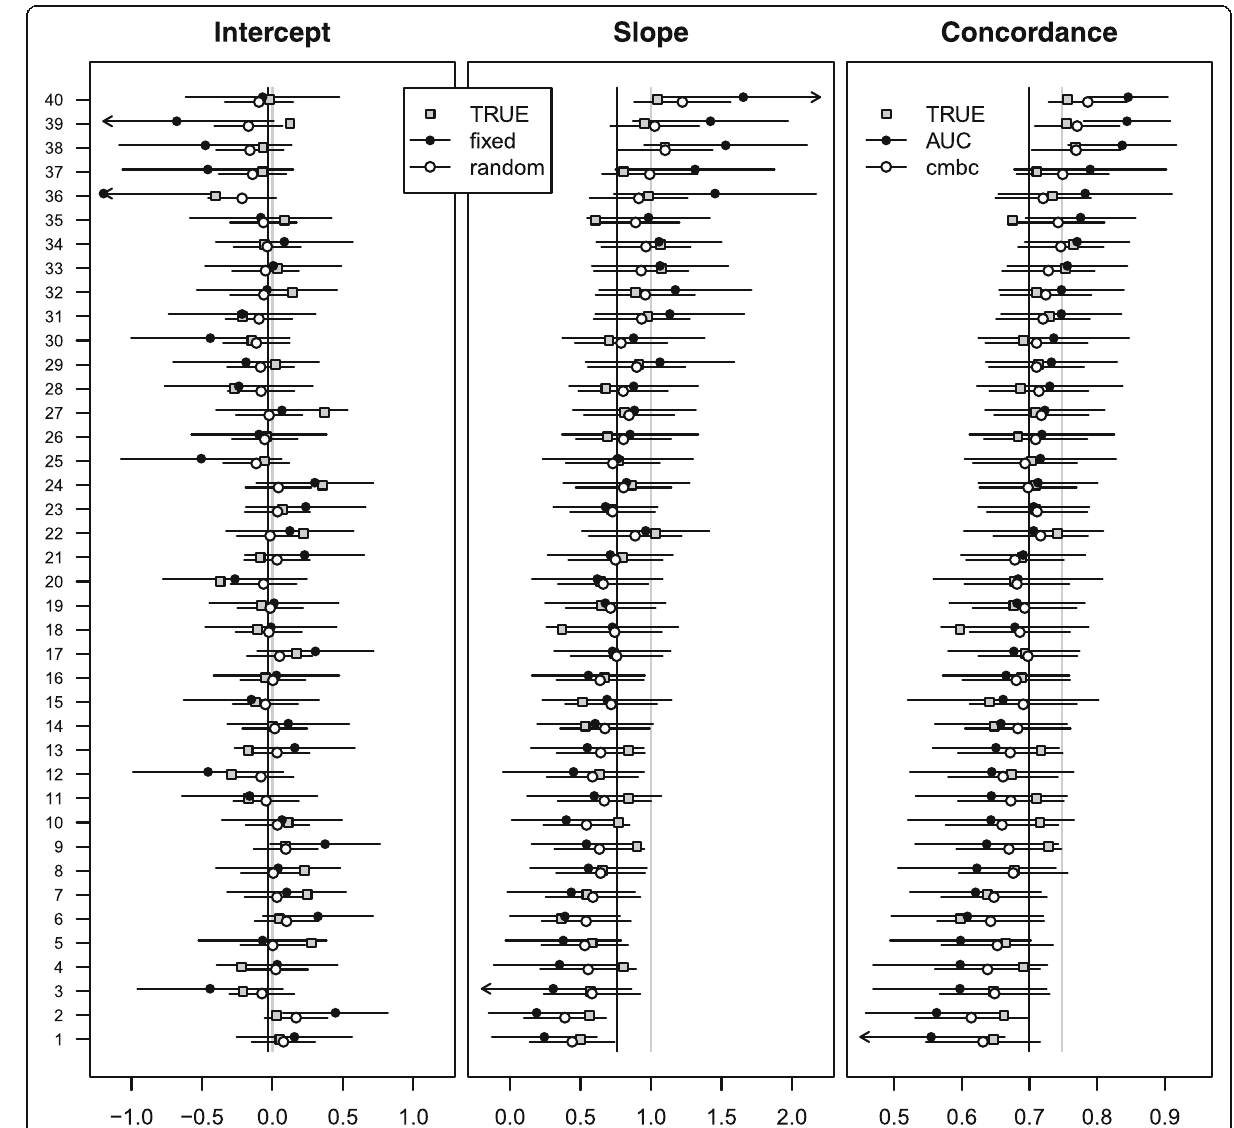
Fig. 6 Performance measures across 40 centers of 200 simulated patients with reduced overall predictive ability. Gray squares represent true values of intercept, slope, and concordance probability. Closed dots represent fixed effect intercept estimates; fixed effect slope estimates; and c-indexes in the first, second, and third panel, respectively. Open dots represent random effects intercept estimates; random effects slope estimates; and calibrated model-based concordance estimates in the first, second, and third panel, respectively. Gray vertical lines represent effect estimates of intercept and slope in the original regression model, together with the expected pooled concordance. Black vertical lines represent fixed effect estimates of intercept and slope in a multilevel regression model, together with the expected pooled